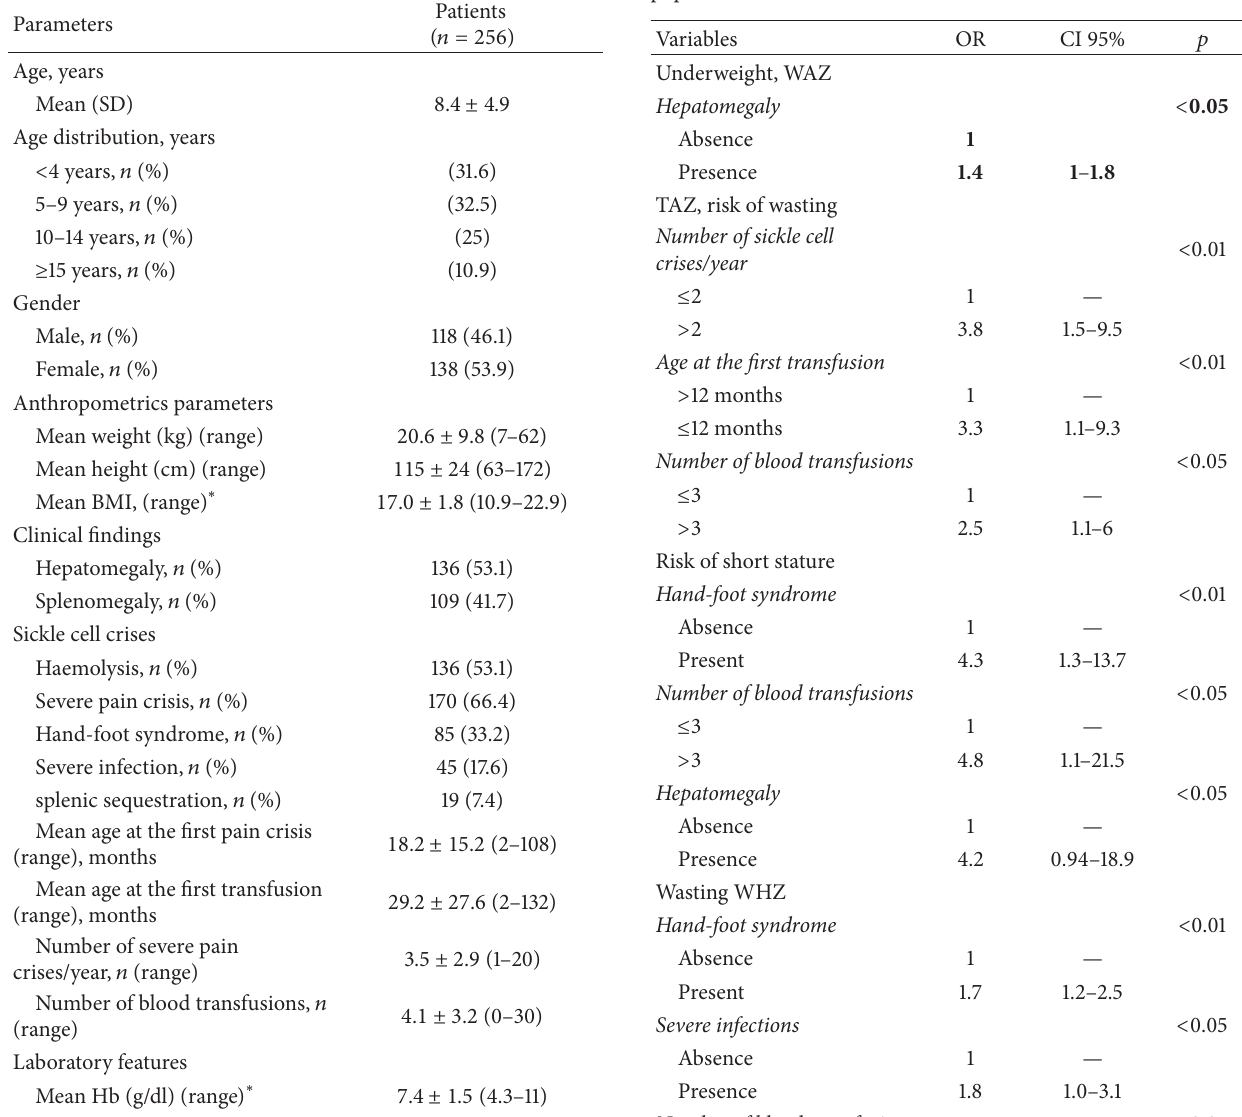
Table 1: Characteristics of the study population. Table 2: Factors associated with a risk of stunting in the study